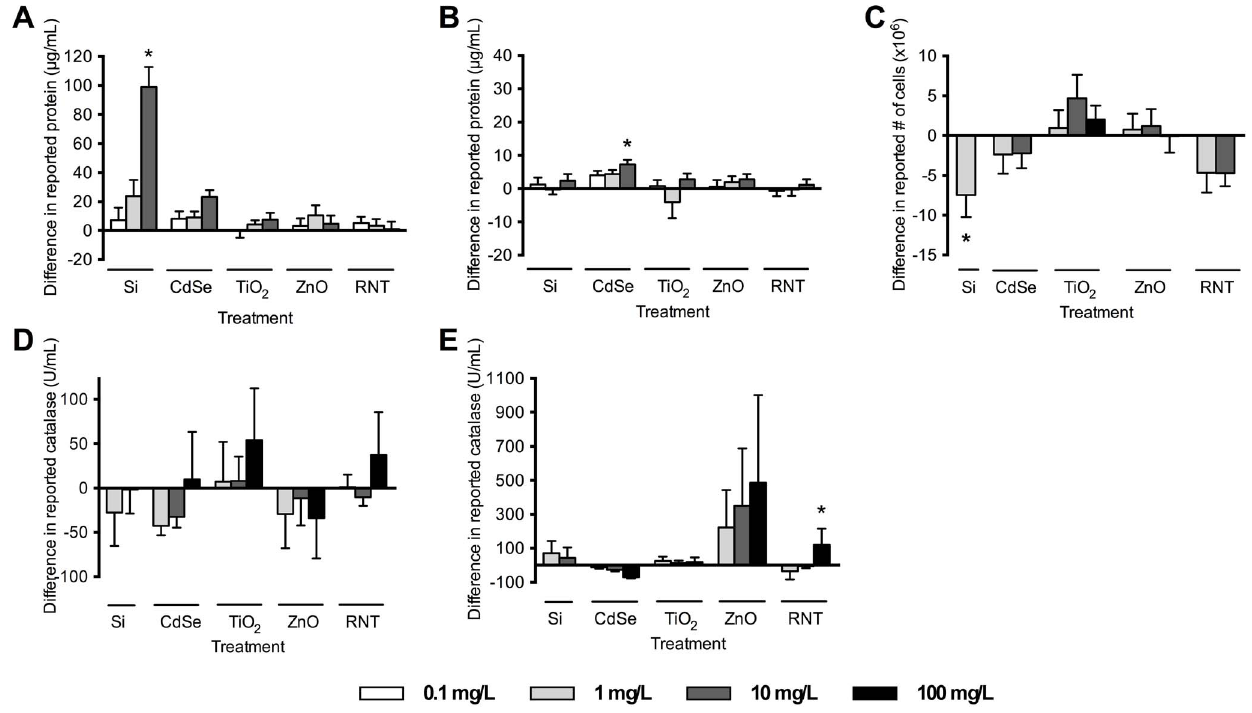
Figure 4. Assessment of nanoparticle interference with the assays components, with addition of analyte. (A) BCA protein assay with 250 m g/mL BSA addition; (B) Bradford protein assay with 40 m g/mL BSA addition; (C) LDH assay with 12.5 6 10 6 lysed cells; (D) Catalase assay with 250 U/mL catalase addition (excitation 531 nm, emission 595 nm); (E) Catalase assay with 250 U/mL catalase addition (absorbance 560 nm). * indicates significantly different than control (p , 0.05, ANOVA followed by Dunnett’s post-hoc comparison).